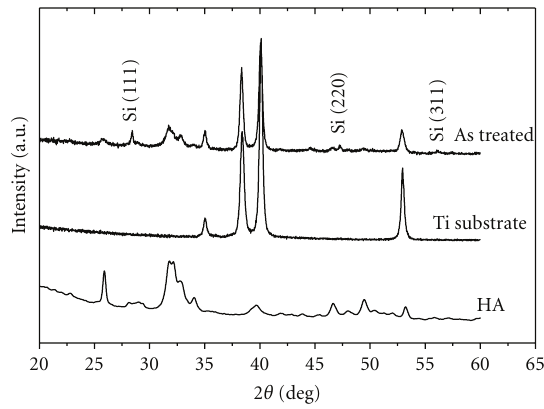
Figure 15: XRD patterns of the SiHA-coated Ti